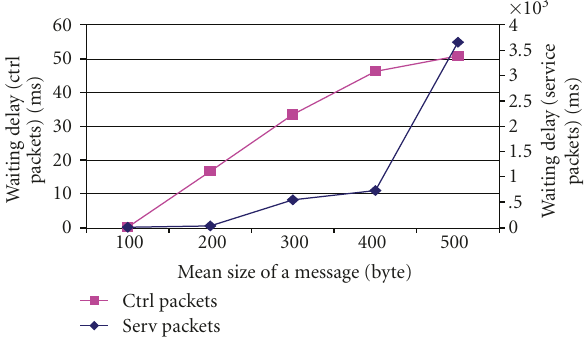
Figure 13: Delay versus Mean Message Size (message generation rate = 150msgs/s and mean number of neighbors = 50).